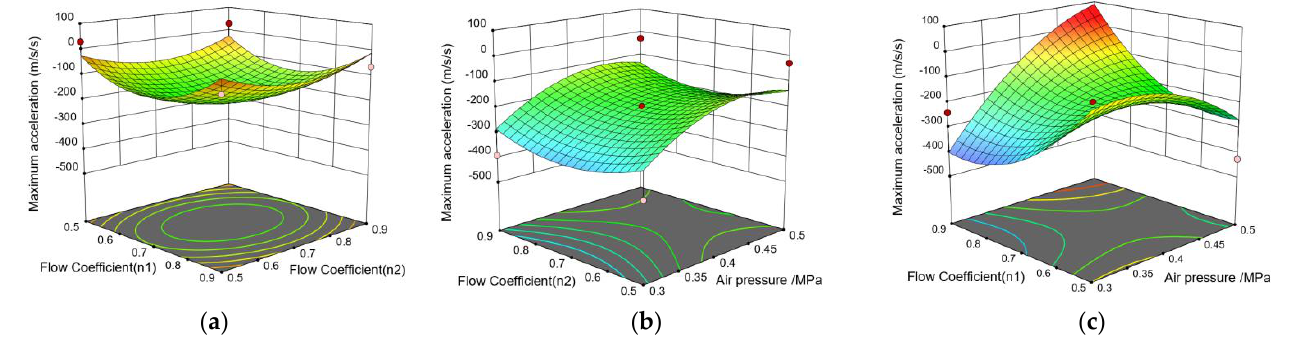
Figure 8. ( a ) Response surface of the effect of n 1 and n 2 on the maximum acceleration of the cylinder when p 1 = 0.4 MPa; ( b ) response surface of the effect of p 1 and n 2 on the maximum acceleration of the cylinder when n 1 = 0.7; ( c ) response surface of the effect of p 1 and n 1 on the maximum acceleration of the cylinder when n 2 = 0.7.